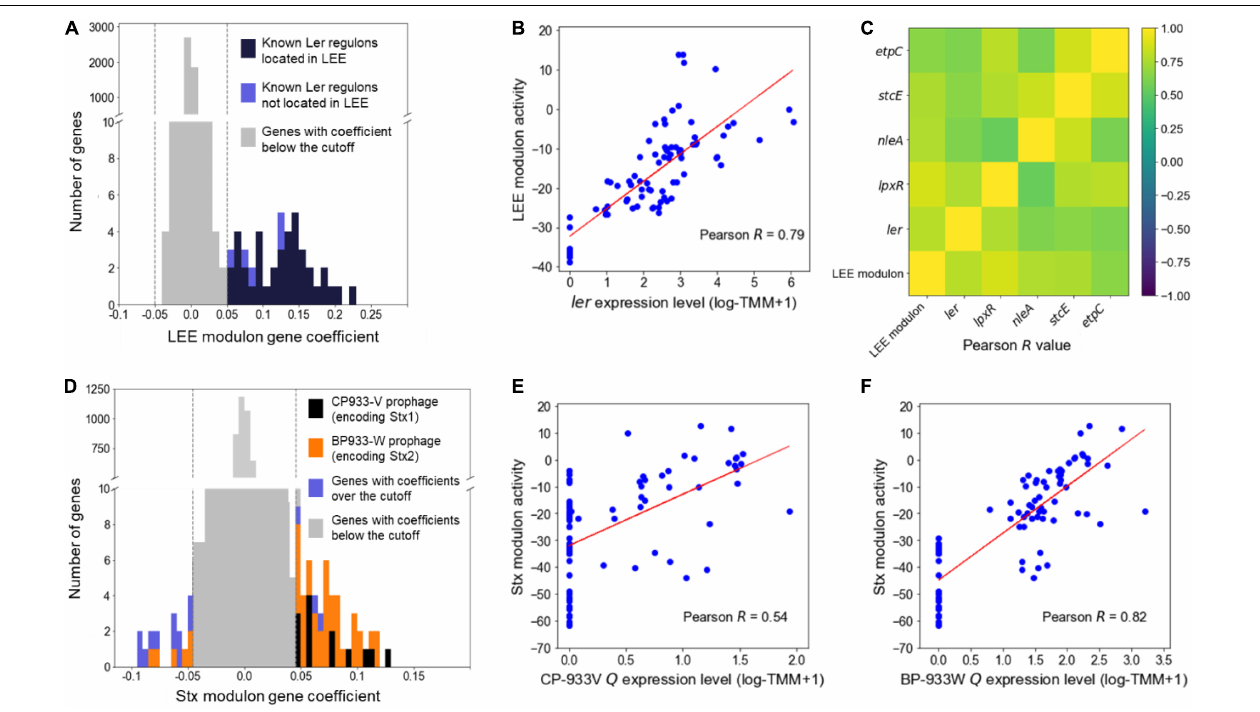
FIGURE 1 | Validation of the LEE and Stx modulons. Histograms of the gene coefficients of the element genes in the LEE (A) and the Stx modulons (D) . The dotted lines in the boxes show the cut-off values of the gene coefficients in each modulon. The colors of the bars represent the classifications of the genes as indicated in the plots. The scatter plots of the activities of the LEE modulon and the expression levels of the ler (B) , the activities of the Stx modulon and the expression levels of the CP-933V antiterminator Q (E) , and the activities of the Stx modulon and the expression levels of the BP-933W antiterminator Q (F) . The Pearson R values between the activities of the modulons and the expression levels of their related TF are denoted in the boxes. Each dot of the plots represents a single biological replicate. Red lines represent the regression lines of the plots. (C) Ordered correlation matrix. Colors indicate the Pearson R values between the activities of the LEE modulon and the expression levels of the Ler regulon that are not located in the LEE. Yellow and indigo represent the strongest positive (+1) and negative (–1) correlation,